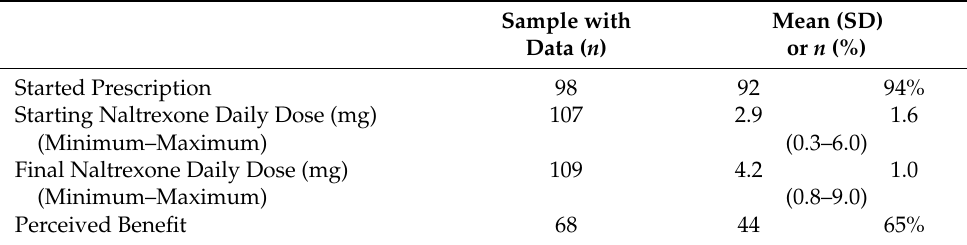
Table 2. Low-Dose Naltrexone Usage ( n =